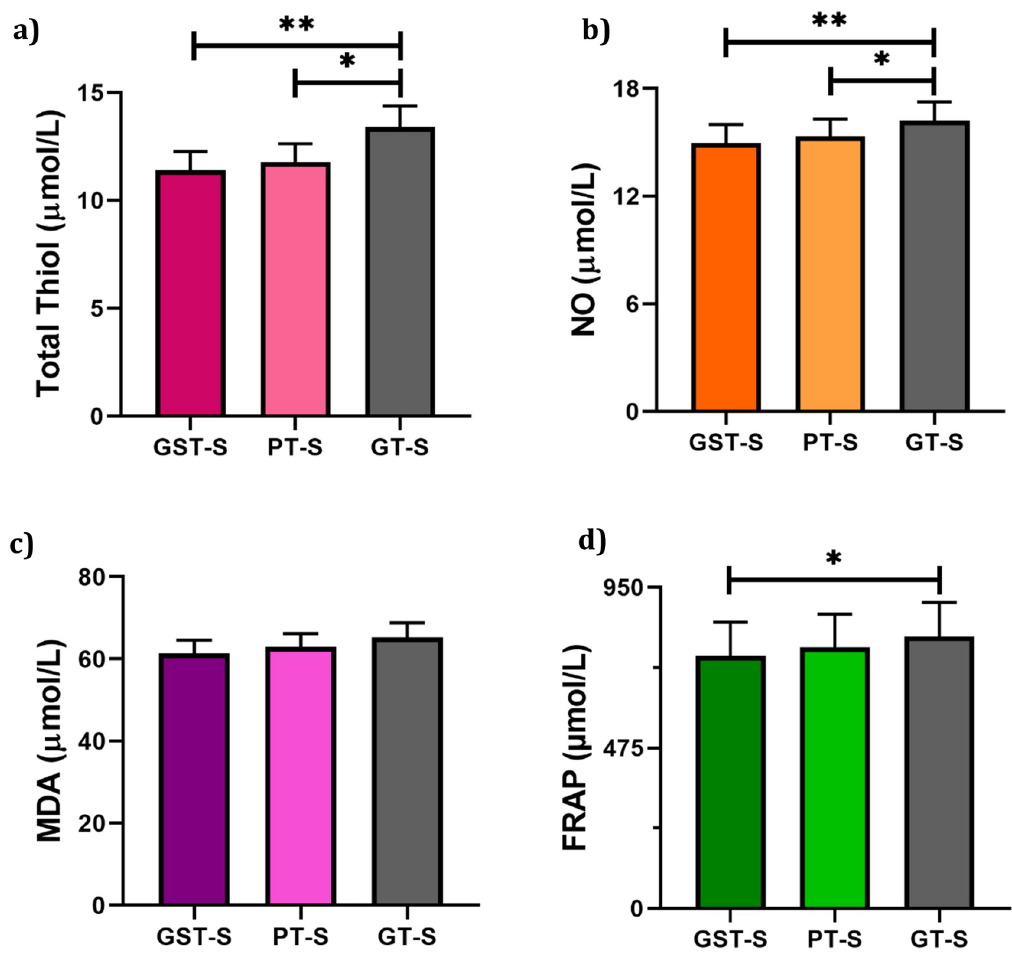
Fig 1. The comparison of mean concentration of (a) total Thiol, (b) NO, (c) MDA, and (d) FRAP levels in GST, GT, and PT. Wilcoxon matched paired test was used, � < 0.05, �� <